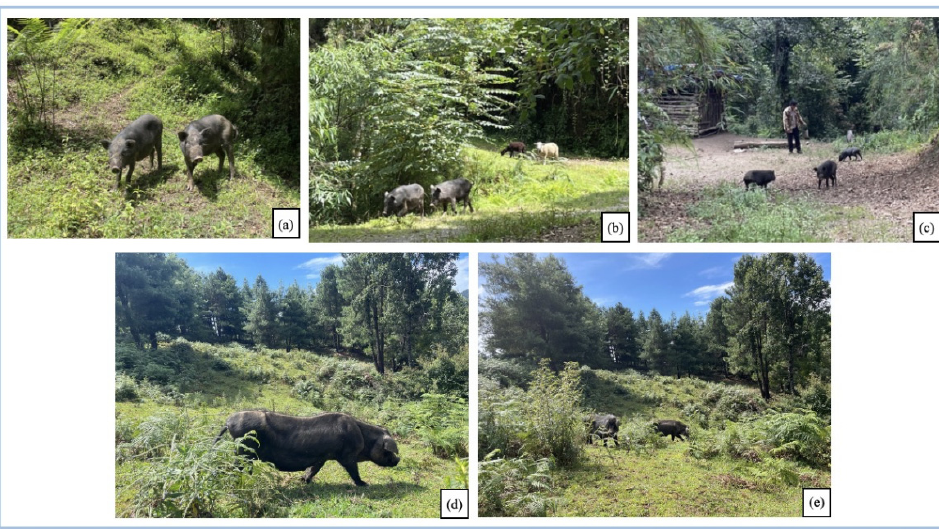
Figure 3. The semi-wild and free-range model to manage Gaoligongshan pigs. ( a ) Gaoligongshan pig cubs; ( b ) Gaoligongshan pigs mixed with cattle and sheep in grazing; ( c ) a farmer is feeding the piglets; ( d ) an adult Gaoligongshan pig; ( e ) the living habitat of Gaoligongshan pigs. (( a – c ) photo by Xingcen Zhao, ( d , e ) photo by Yanan Chu, August 2022, ( a – c ) photographed in Laowo village, ( d , e ) photographed in Chongren village).